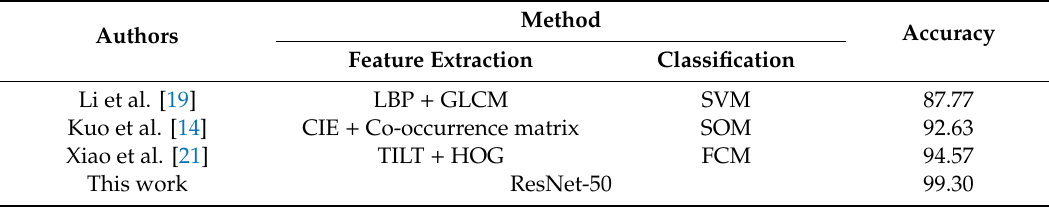
Table 3. Performance comparison against baseline